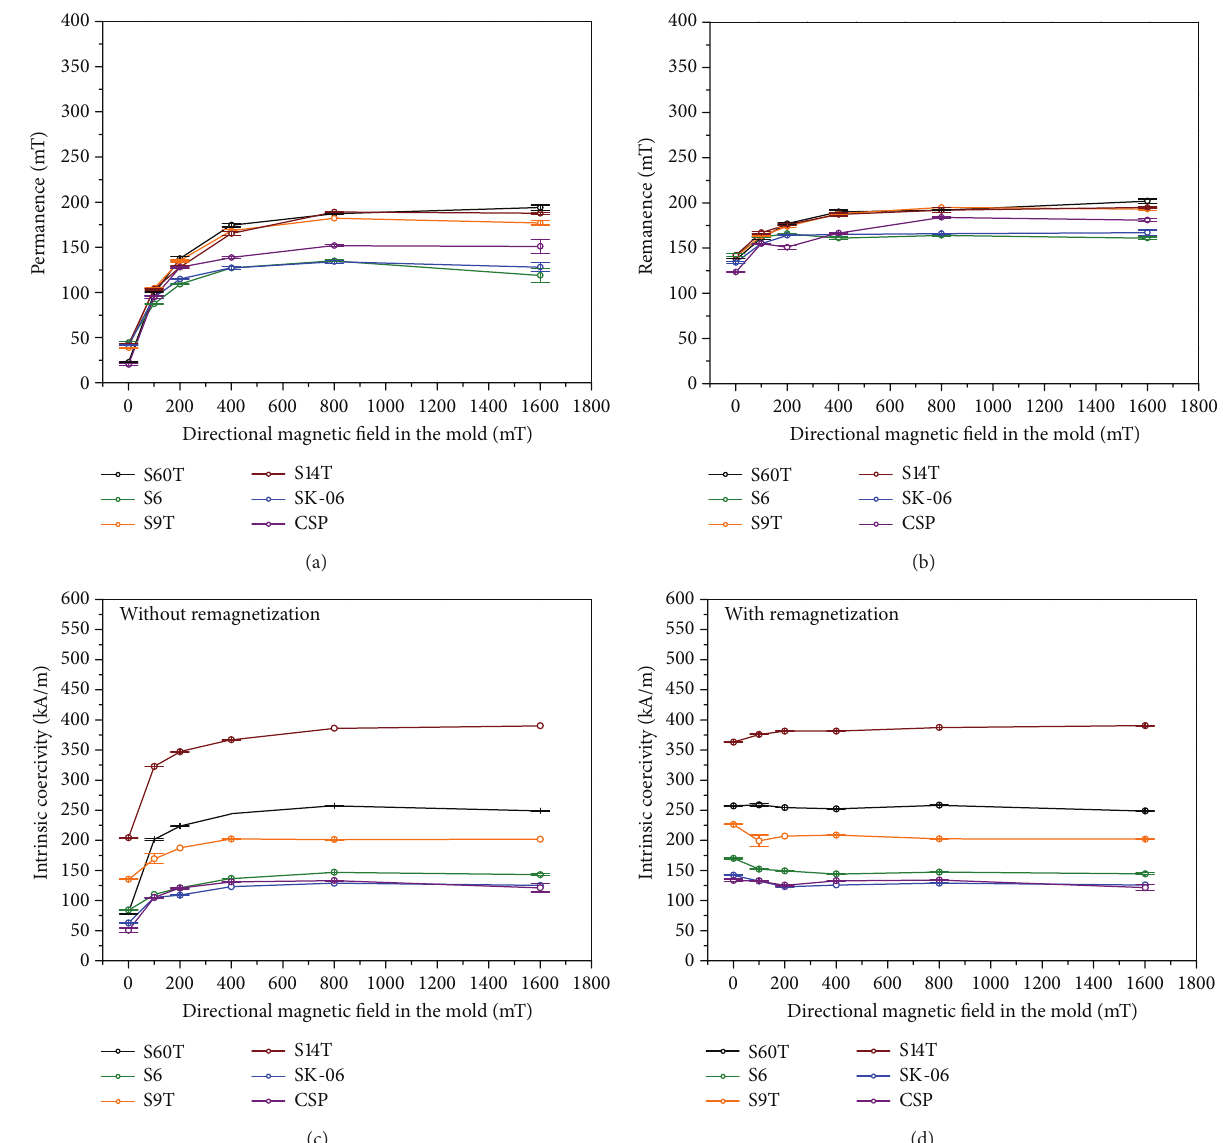
Figure 3: Magnetic properties of green compacts with different SrFeO powders, as a function of the directional magnetic field in the mold. (a) Permanence, (b) remanence, (c) intrinsic coercivity (without remagnetization), and (d) intrinsic coercivity (with